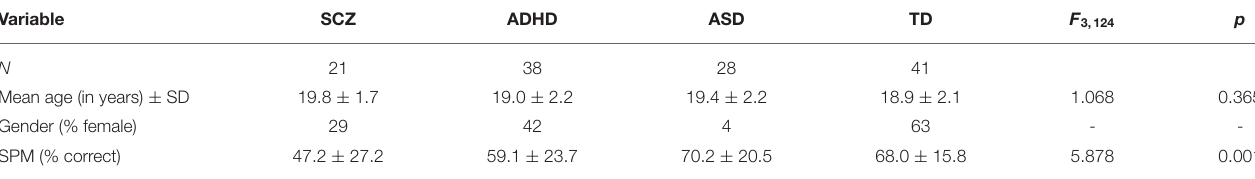
TABLE 1 | Group characteristics.